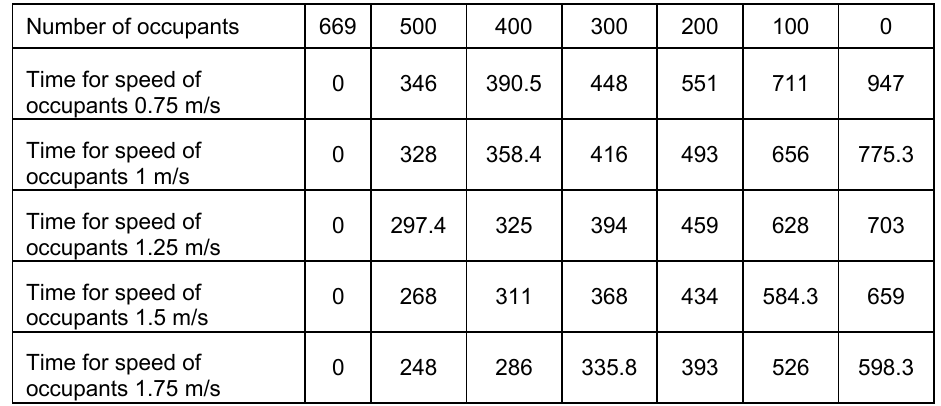
Table 17 – Simulation results in seconds for the third scenario, with elevators disabled and the first and the second entrances/exits blocked and for the occupants’ speeds